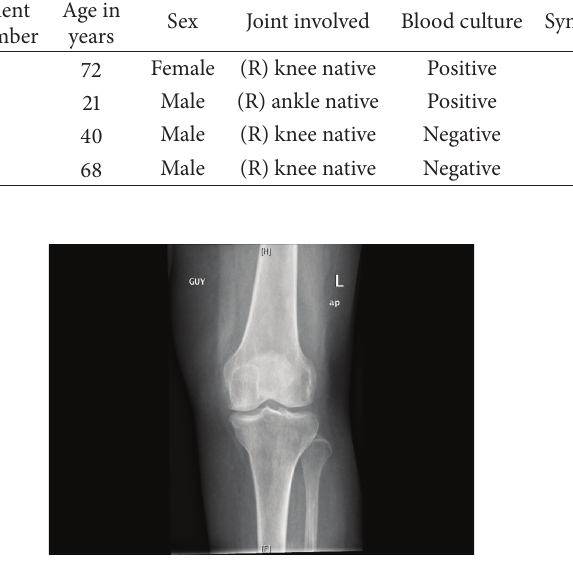
Figure 3: MRI showing a large (R) ankle effusion with tibialis posterior